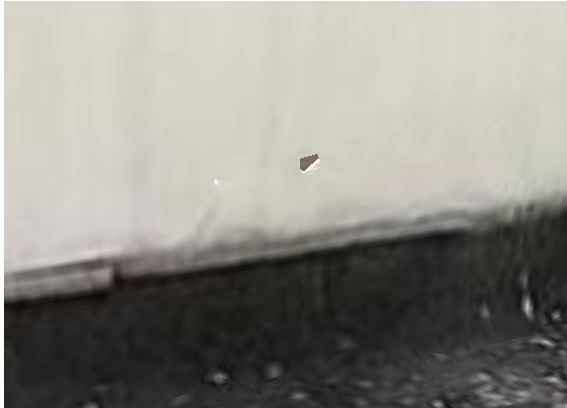
Figure 8. Small hole on the wall of the 3D model reconstructed with M300RTK at an altitude of 80 m.